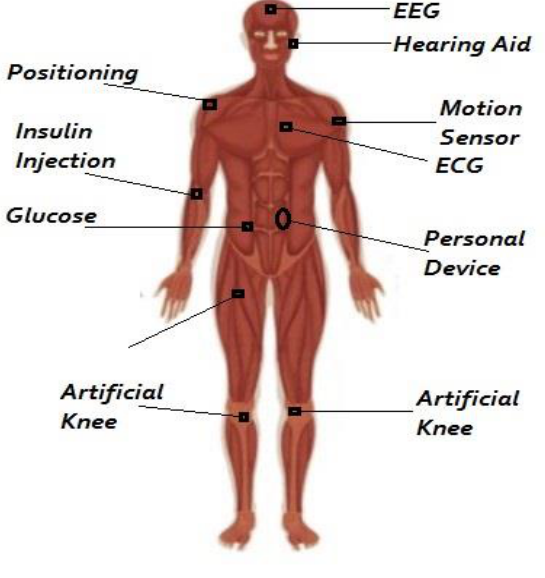
Fig. 1. Sensors implantation on human